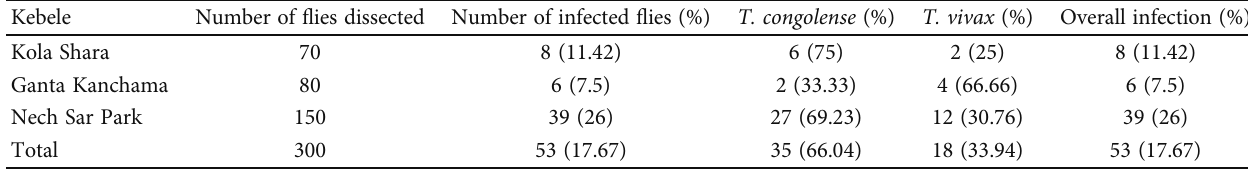
Table 3: Trypanosome infection rate in G. pallidipes and identi fi ed trypanosome species. Kebele